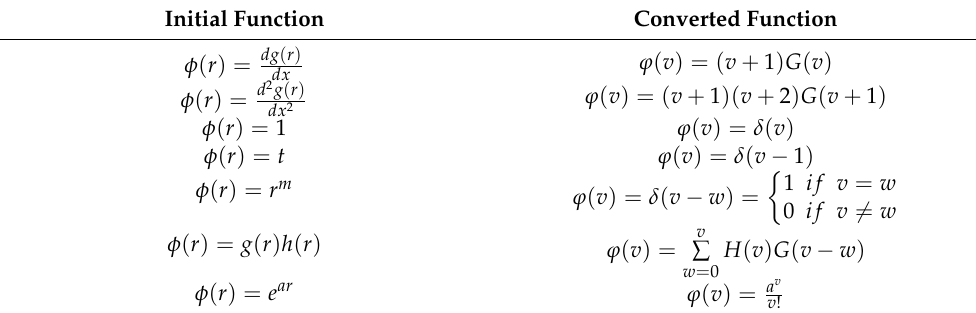
Table 1. Fundamental definitions of